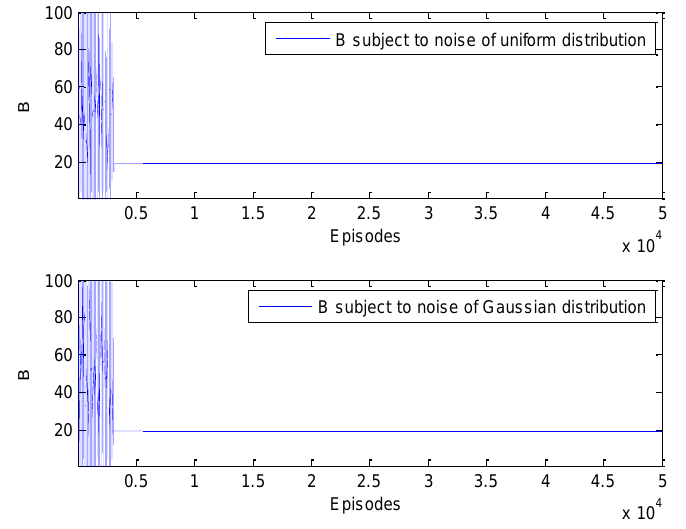
Figure 6. The episode training process of viscous damping coefficient (B was predetermined as 20).